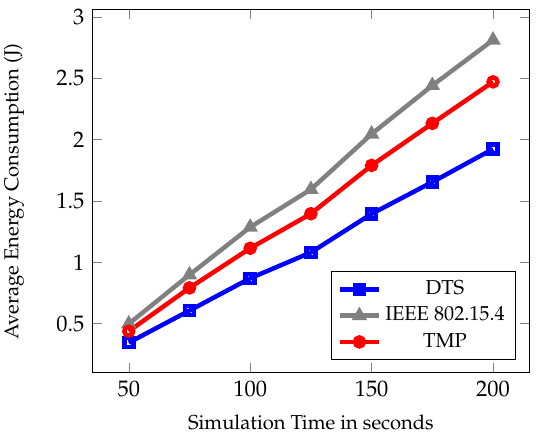
Figure 9. Average energy consumption under different simulation